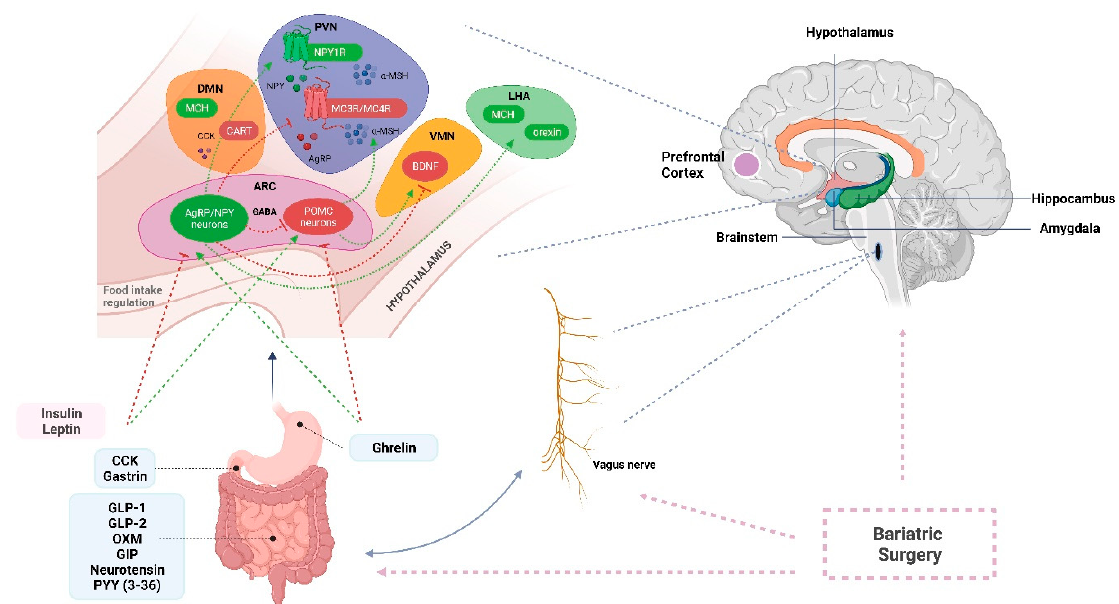
Figure 2. Neurohormonal circuits and neuronal signals derived from the hypothalamus and other centers regulating appetite and energy homeostasis, which may be affected by bariatric surgery. (Created in https://biorender.com/, accessed on 13 March 2022) AgRP: agouti-related peptide, ARC: